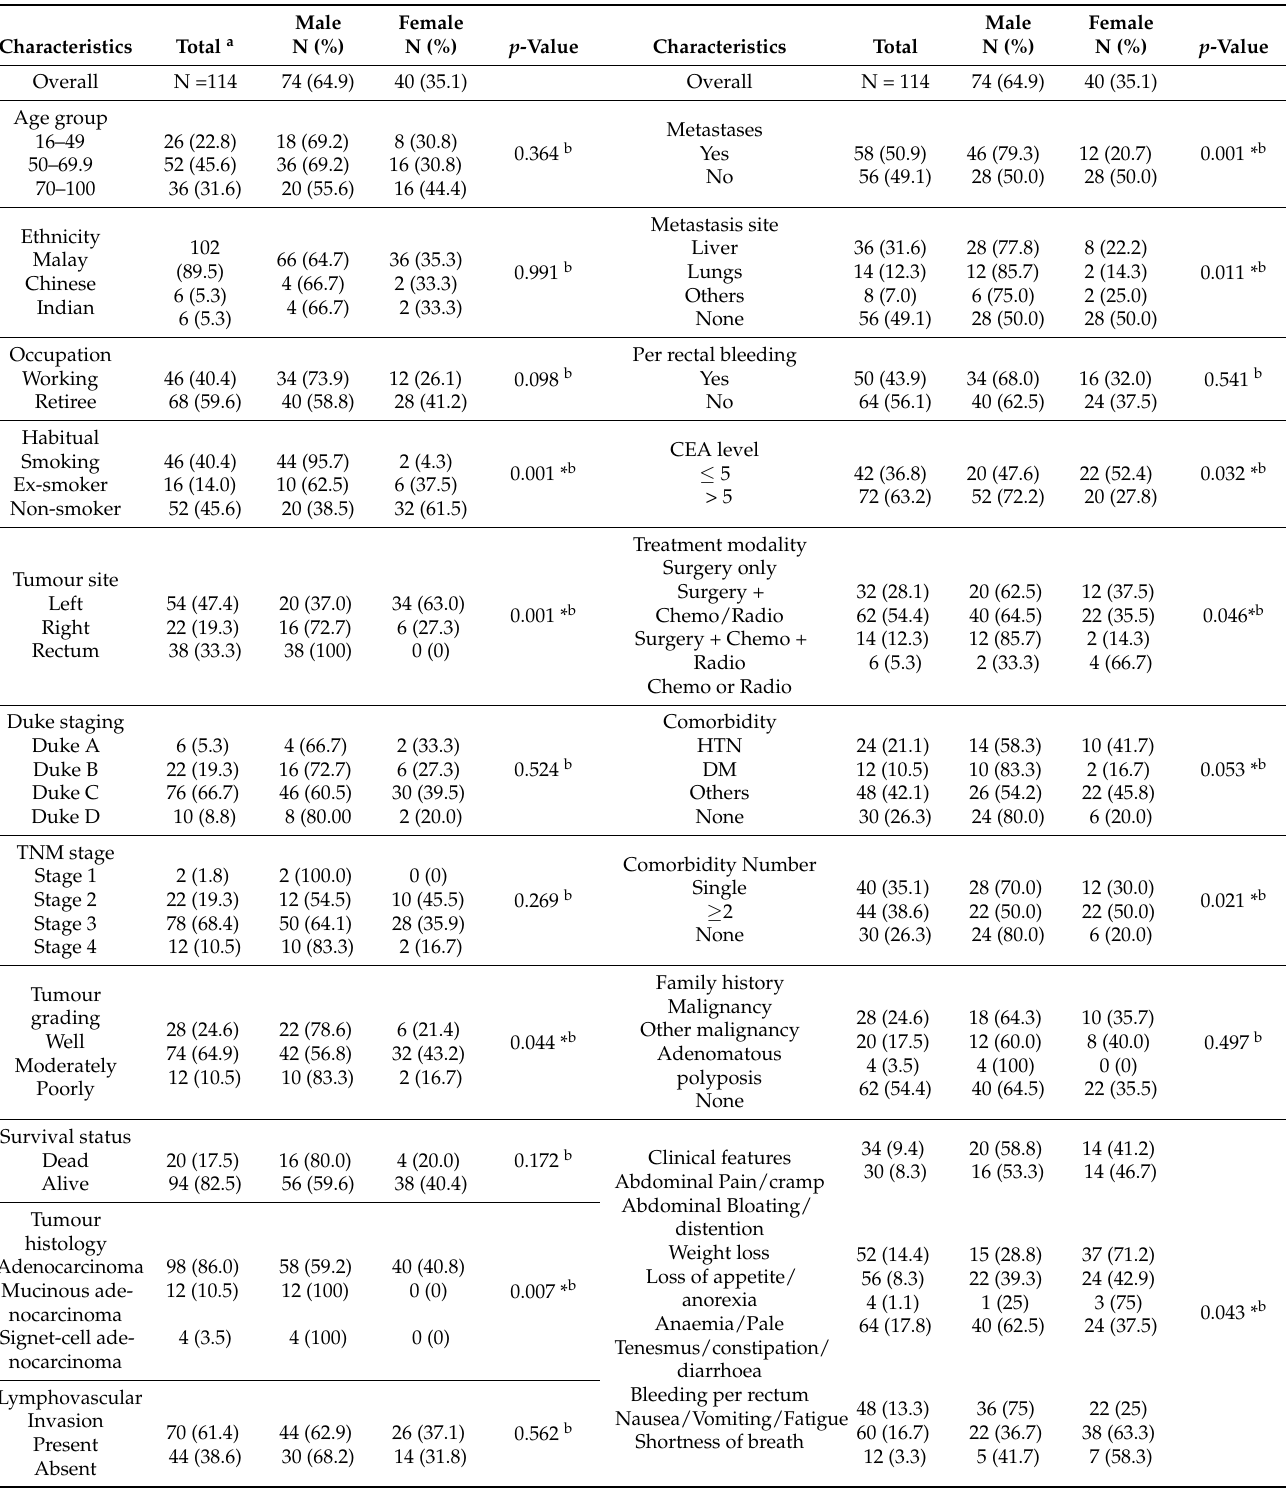
Table 3. Demographic data of the